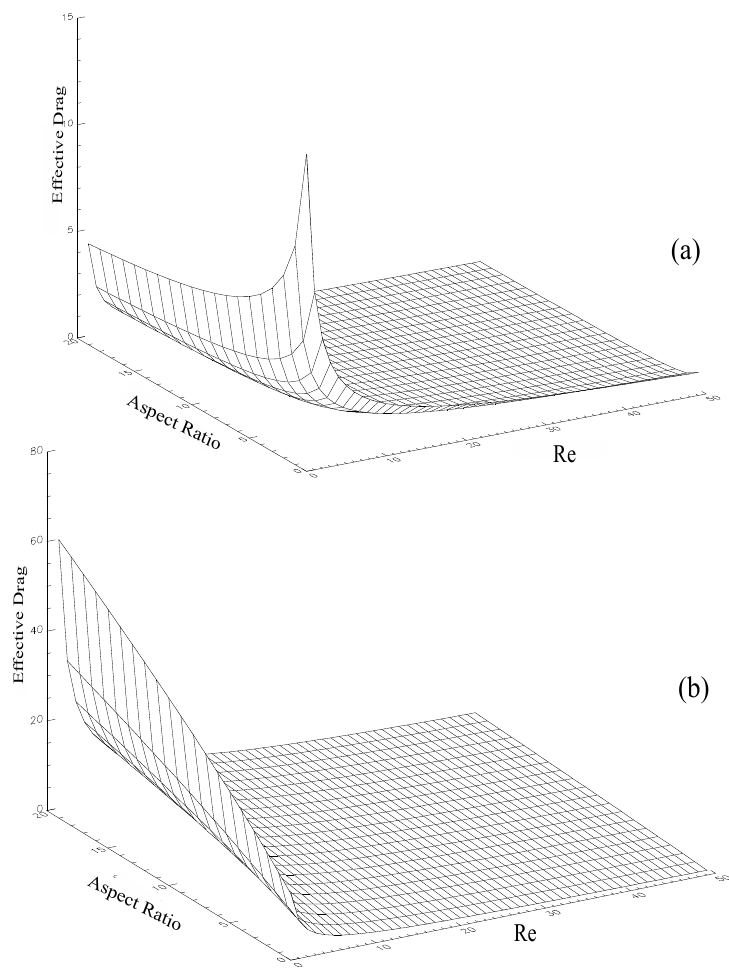
Figure 3. Drag coefficient correction (Equation (20)) in the ( a ) ˆ x , ˆ z directions; ( b ) ˆ y -directon.